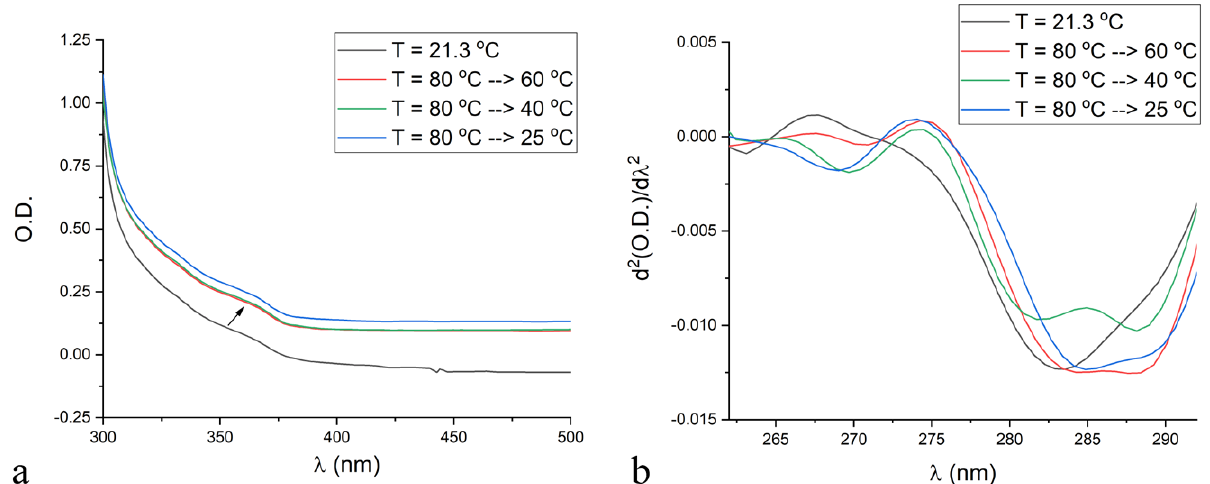
Figure 9. Optical density (a) and its second derivative (b) as a function of wavelength in the selected visible light ranges for DI water main- tained at room temperature (21.3 o C) and DI water heated to 80 o C and measured first when it cooled down to 60 o C (T = 80 o C → 60 o C), then when it cooled down to 40 o C (T = 80 o C → 40 o C), and finally when it cooled down to room temperature (T = 80 o C → 25 o